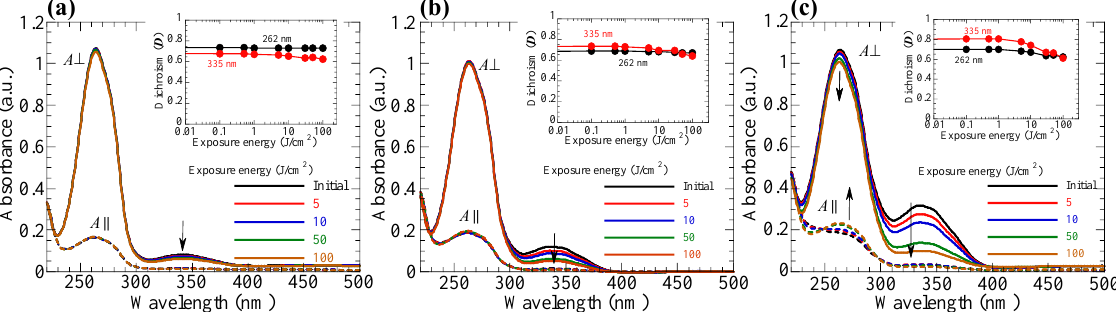
Figure 11. Changes in the polarized absorption spectra when oriented ( a ) PN10 , ( b ) PN20 , and ( c ) PN50 films are exposed to LP 365-nm light with E parallel to the orientation direction. Insets plot the D values as a function of exposure energy.